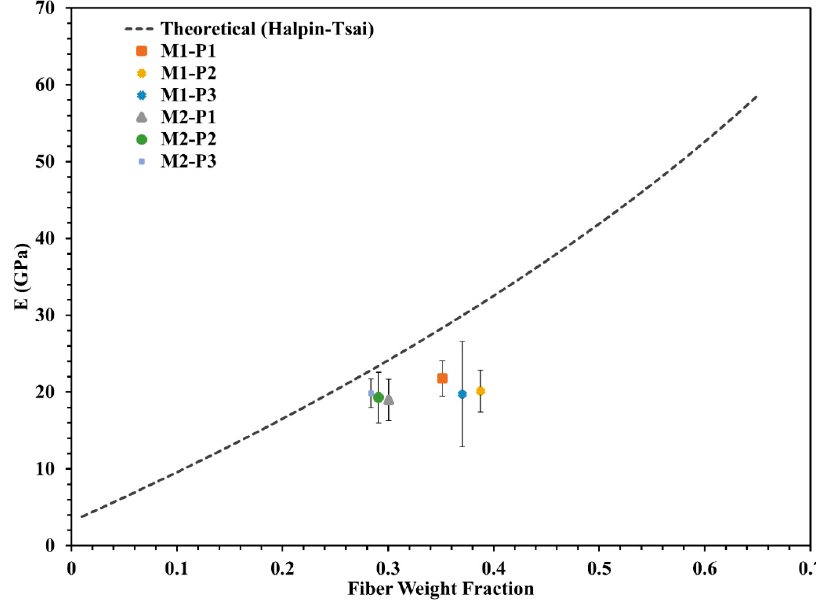
Figure 9. Average tensile modulus versus fiber weight fraction of each plate in both sets of Method 1 and Method 2. The blue line indicates the theoretical value calculated using the Halpin-Tsai equations. Figure 10 represents the tensile strength comparison between theoretical and experimental values for the plates of both sets. In Method 1, plates had a standard deviation of 21, 31 and 36 MPa (valued at 20%, 24.2% and 24%, respectively). Method 2 plates showed narrower standard deviation at 15, 17 and 19 MPa (valued at 10%, 14% and 9.8%). The cluster of the average tensile strength from samples of Method 1 showed a wider spread due to variability in weight content, and an average difference of 46% from theoretical value. The average cluster for Method 2 was closer to the theoretical value, with only a 28% difference. Such differences can be attributed to voids in the samples. The microstructure dependency plays an important role toward the deviation from theory (which assumes perfect isotropic material). Still, samples produced through Method 2 mats demonstrated a narrower standard deviation that did not surpass 10% between themselves, while the standard deviation for samples produced through Method 1 mats was higher than 20% when